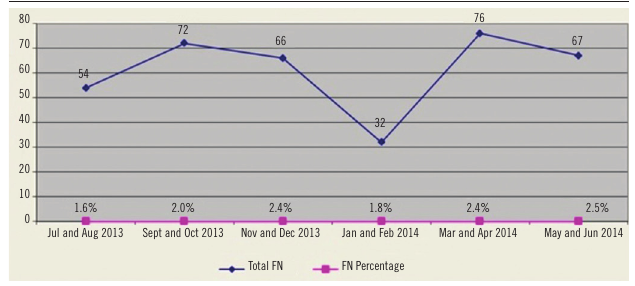
figuRE 2 − Total and percentage of false negative in the period of July 2013 to June 2014, average 2.1% FN: false negative.